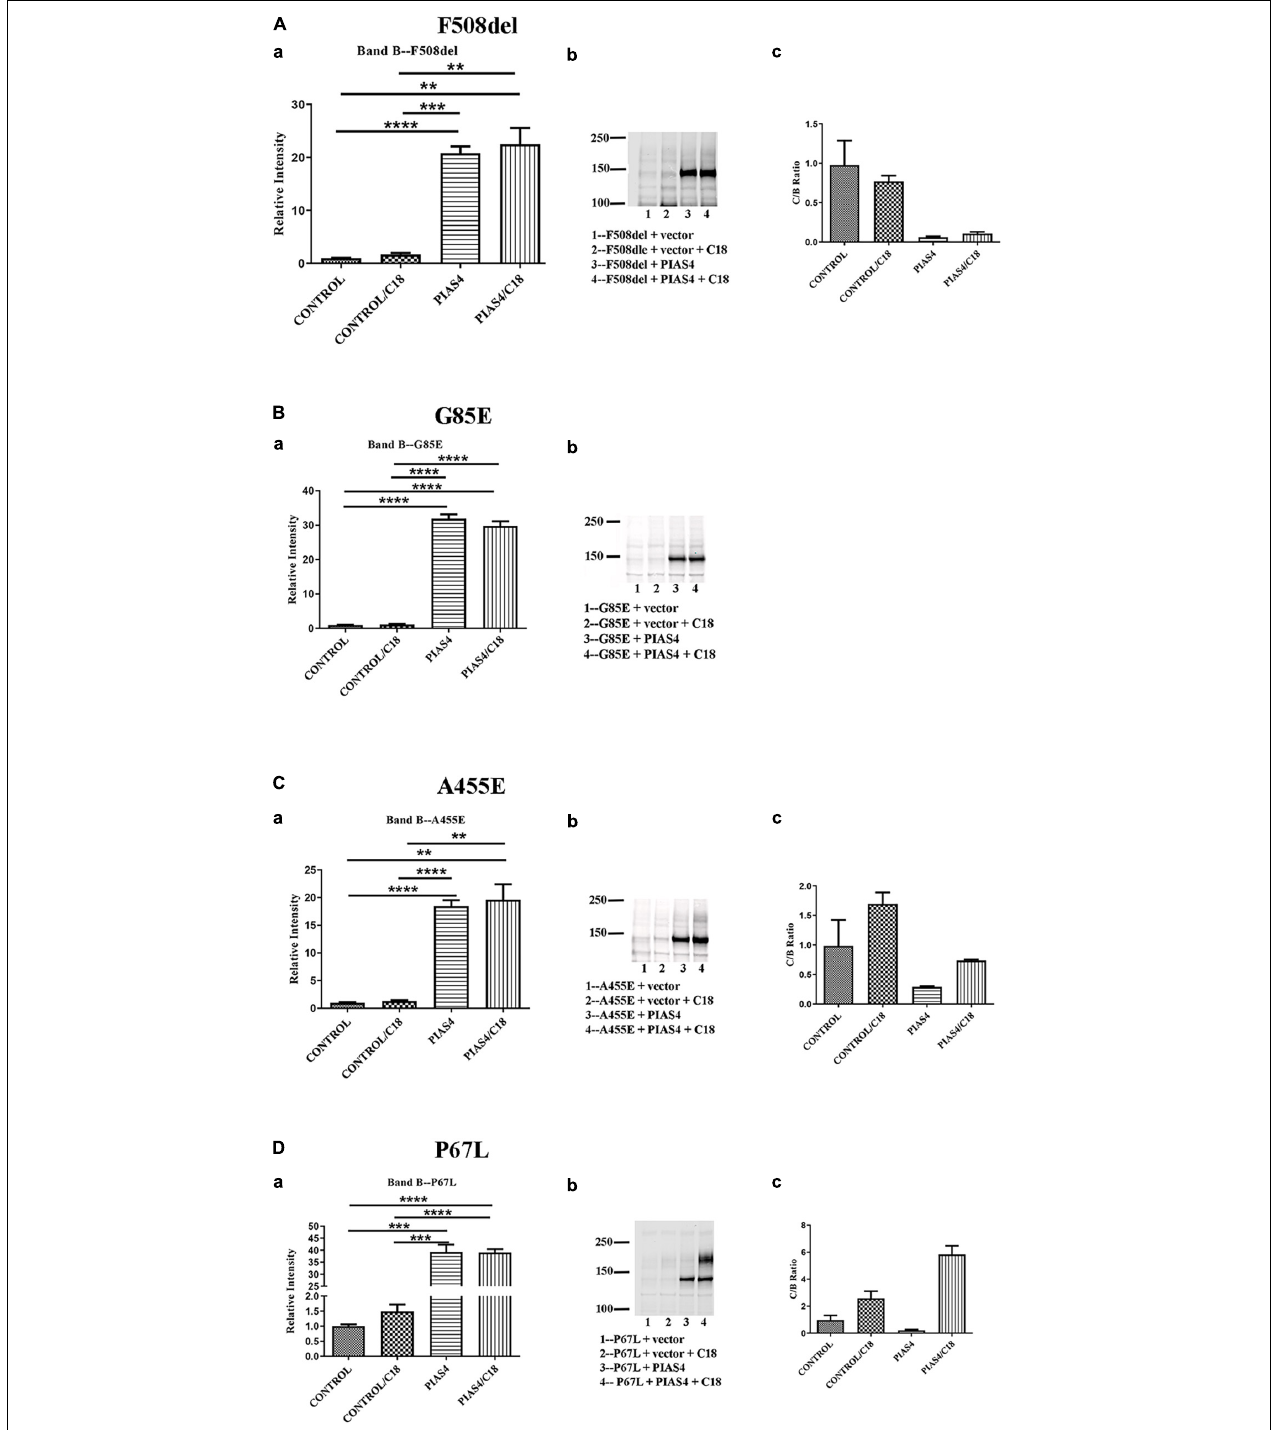
FIGURE 4 | Representative data illustrating the analysis for each of the three categories. (A) Throughput responsive mutant F508del, which is presented as a benchmark for the analysis in view of its significance in CF. (B) Intransigent mutant G85E. The intensity data from three blots generated the mean data for the bar graph. No band C was detected. (C) Throughput responsive mutant A455E. The intensities of the three blots show bands B and C produced by the co-expression of PIAS4 with/without C18. The C:B ratio shows that although band C is produced, the amount is less than control. (D) Folding responsive mutant P67L. The representative blots show the significant generation of band C with the co-expression of PIAS4 and in response to C18. The C:B ratio was 6-fold higher than the control value, indicating corrector-induced mature CFTR generation exceeding the PIAS4-enhanced band B level. * P = 0.01–0.05; ** P = 0.001–0.01; *** P = 0.0001–0.001; **** P = 0.0001.